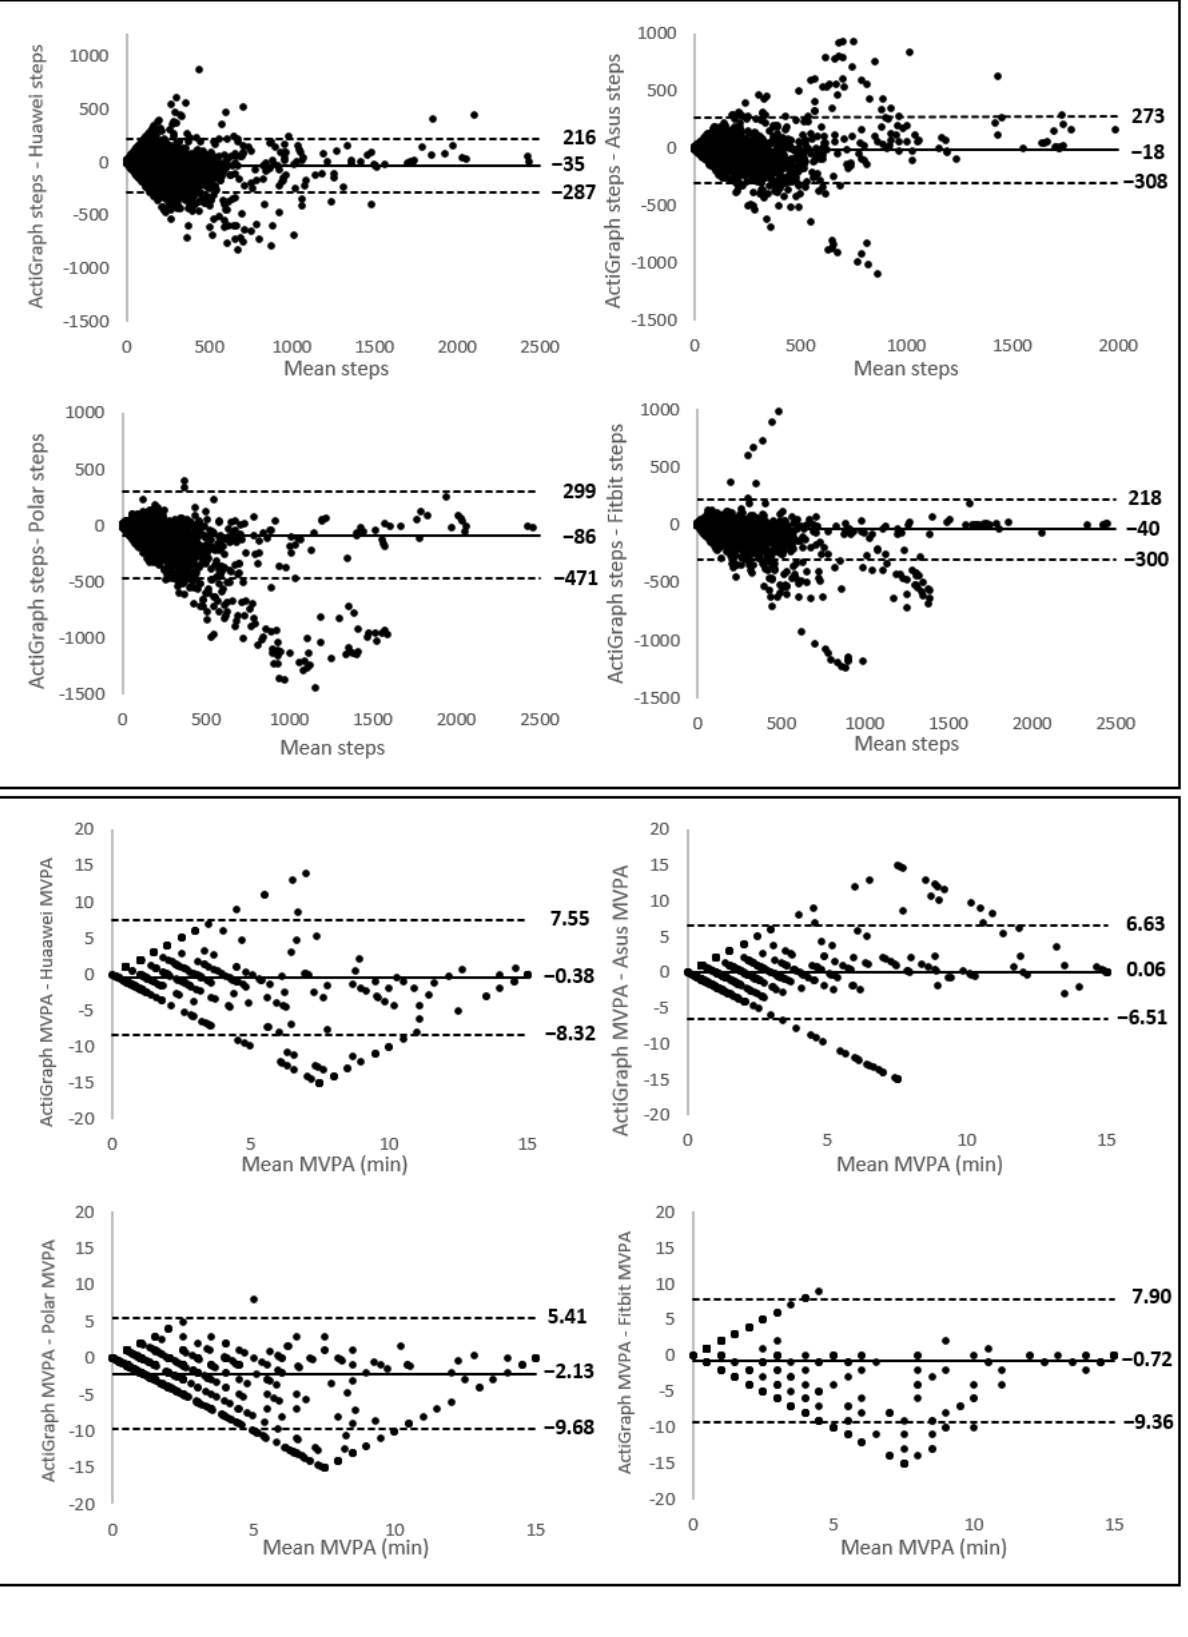
Figure 5. Bland-Altman plots of the wearables. The middle line shows the mean difference (positive values indicate an underestimation of the wearable and negative values indicate an overestimation) between the wearables and the ActiGraph, and the dashed lines indicate the limits of agreement (1.96 × SD of the difference scores). MVPA: moderate to vigorous physical